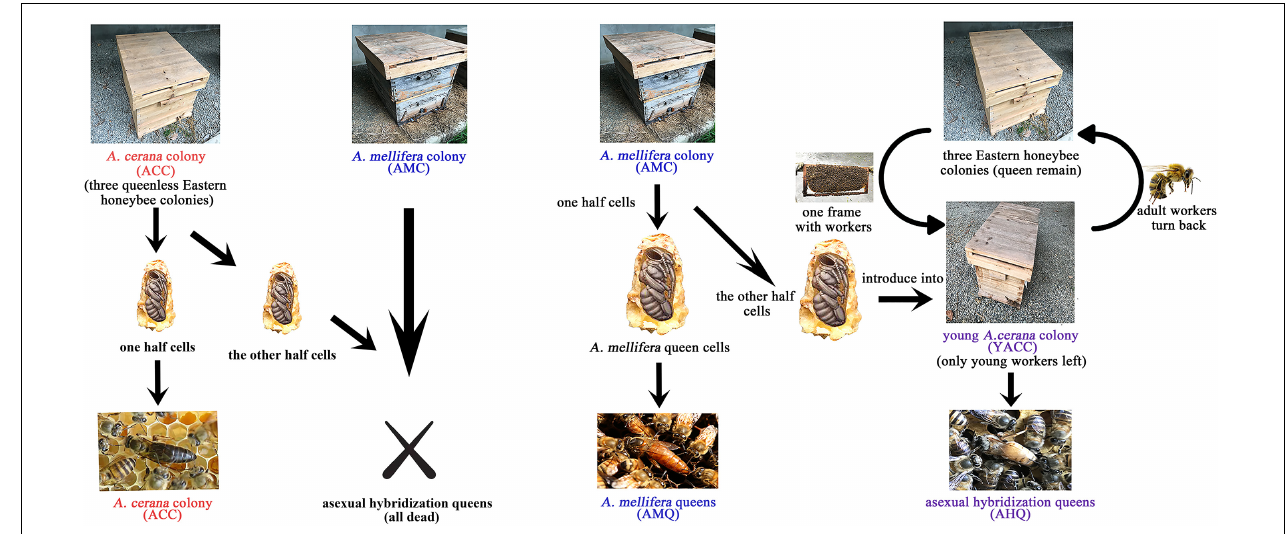
FIGURE 1 | Experimental design. The brief process of ACQs, AHQs, and AMQs included in this study is visualized in this schematic diagram. Experimental details are given in the “Materials and Methods” section. The other opposite crossbreeding ( A. cerana into A. mellifera ) was excluded from this study for lack of